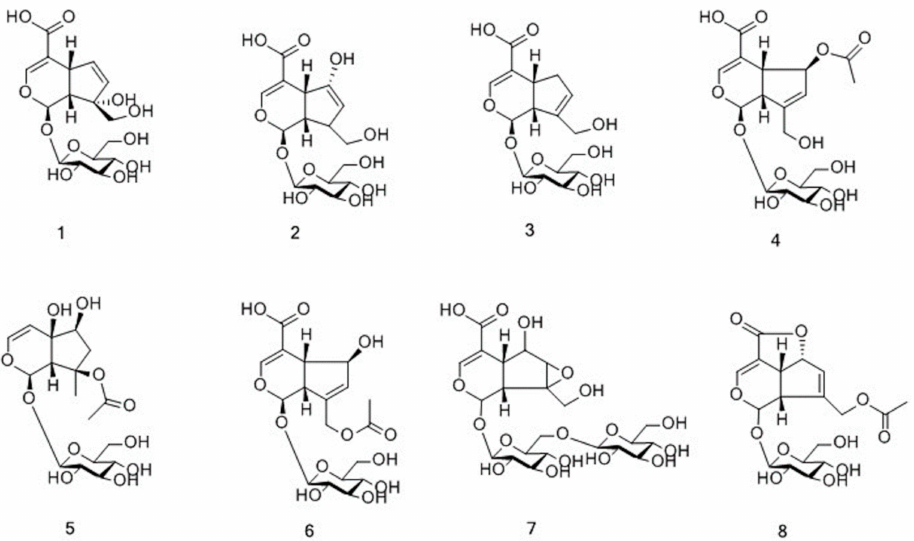
Figure 2. Chemical structures of iridoid glycosides identified in M. citrifolia and M. o ffi